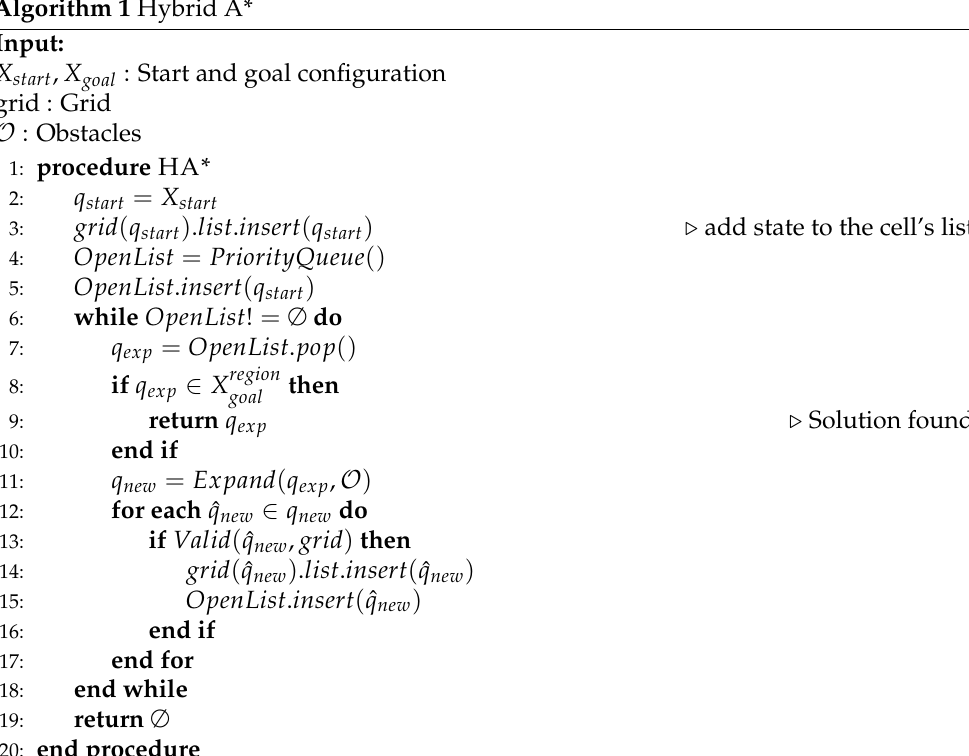
Algorithm 1 Hybrid